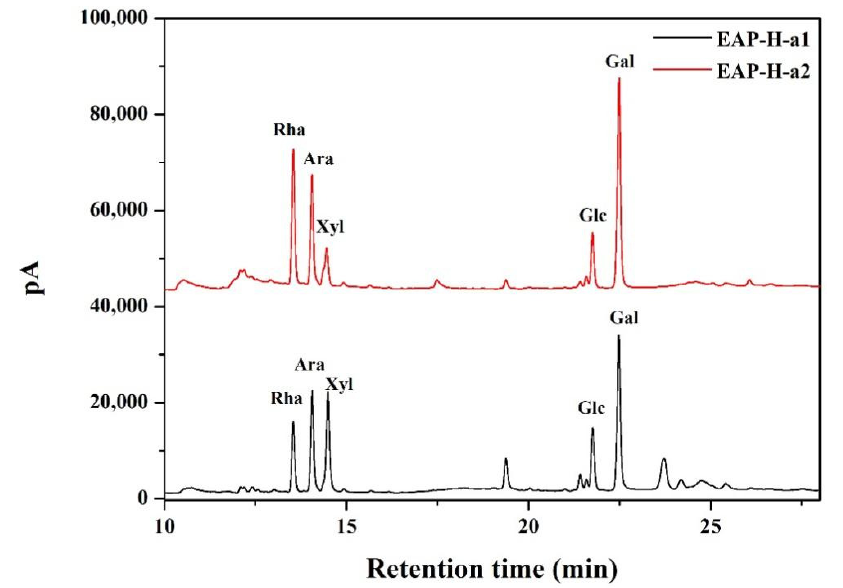
Figure 2. GC spectrum of the polysaccharides.